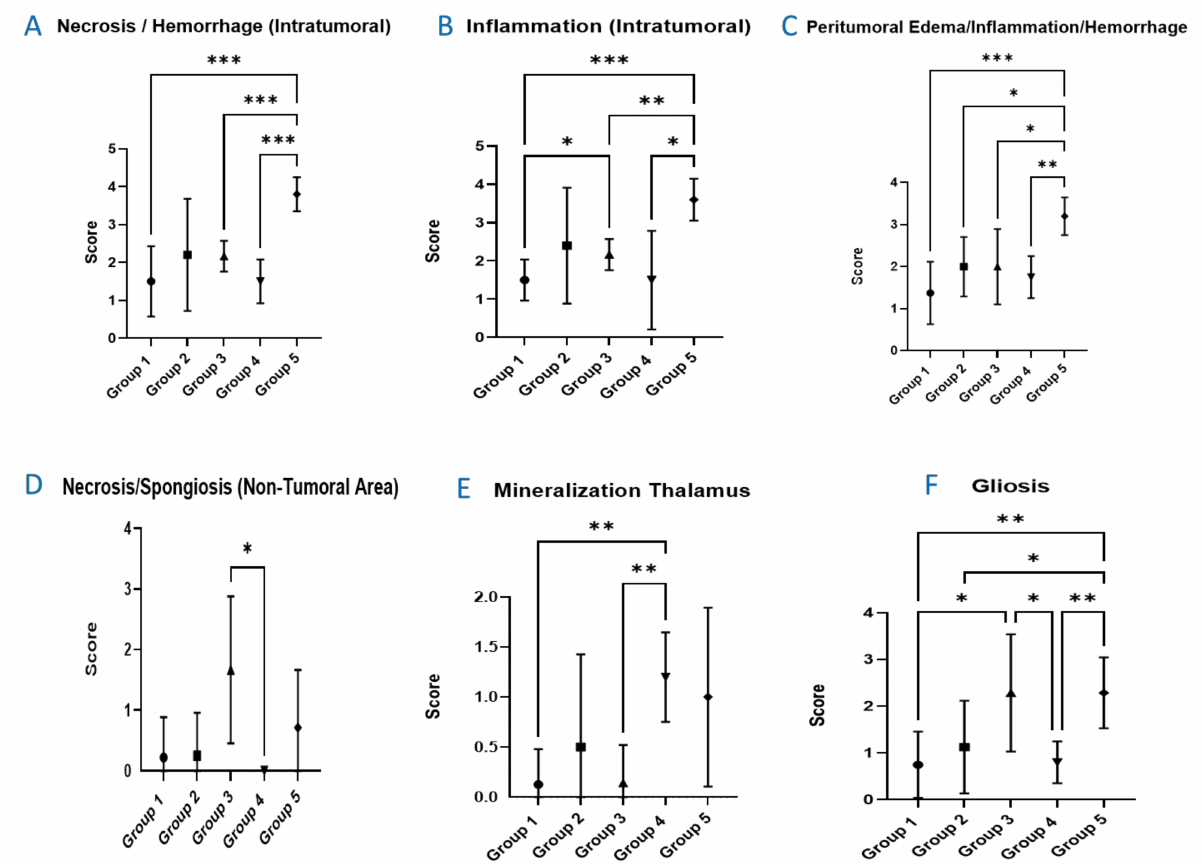
Figure 6. Presentation of the summary results from the histopathology evaluation. ( A ) intratumoral necrosis and hem- orrhage. ( B ) intratumoral inflammation. ( C ) peritumoral edema, hemorrhage, and inflammation. ( D ) non-tumoral area of necrosis and spongiosis. ( E ) mineralization of the thalamus. ( F ) gliosis. Statistically significant differences ( p < 0.05) between different groups are represented in the figure by asterisks. Group 1 represents the non-irradiated controls; Group 2 integrates the animals that received pMBRT in one fraction of 15 Gy/array; Group 3 includes the animals that received pMBRT in two fractions of 15 Gy/array; Group 4 depicts the animals that received pMBRT in two fractions of 20 Gy/array; and Group 5 includes the animals having received broad beam irradiations. Statistically significant differences are indicated by *, ** and *** for p values less or equal than 0.05, 0.01, and 0.001,